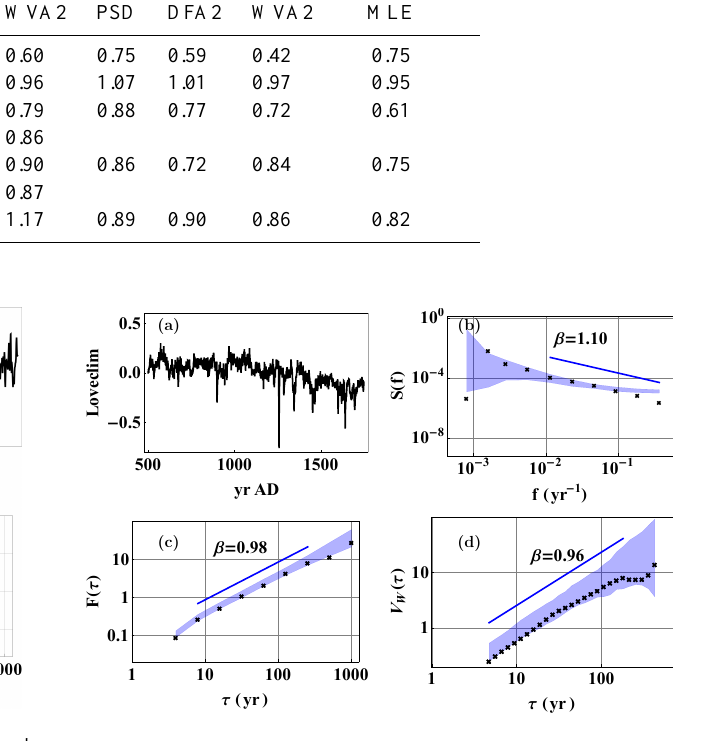
Figure 4. (a) The temperature from the LOVECLIM experiment. (b) PSD, (c) DFA2, and (d) WVA2 applied to the record. The shaded areas are the 95% confidence range for synthetic fGn with β esti- mated by PSD, DFA2 and WVA2. The β -values are estimated from the slopes of the straight lines and the range of scales used for es- timation is indicated by the length and position of these line seg- ments. The estimated β -values are indicated in the